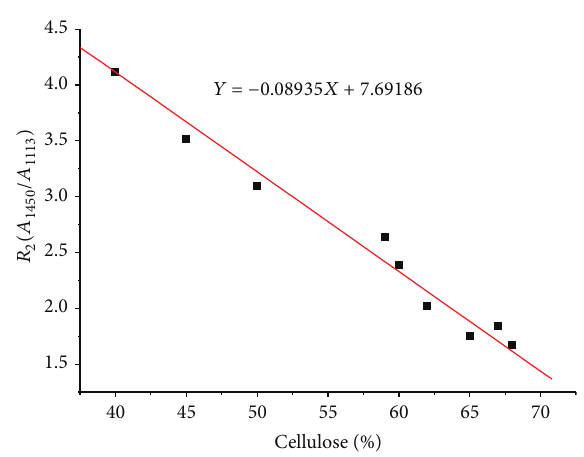
Figure 2: Predictive model for the determination of cellulose in ternary mixtures of